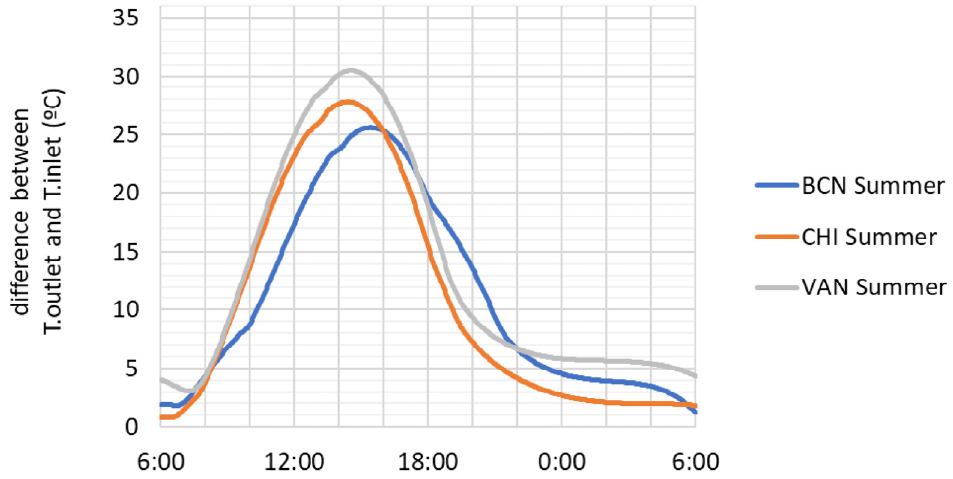
Figure 13. Temperature difference between outlet and inlet air in summer.